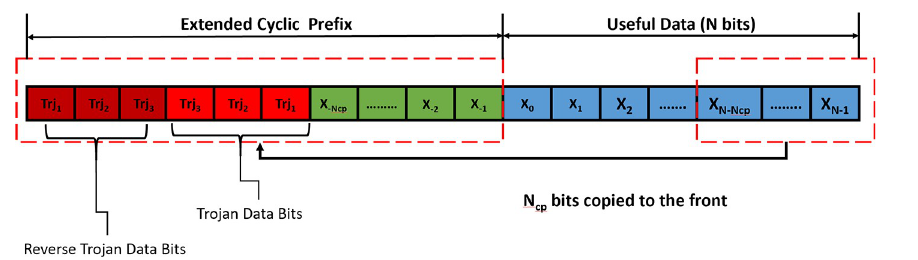
Fig 8. Trojan data insertion in ECP of an OFDM symbol.